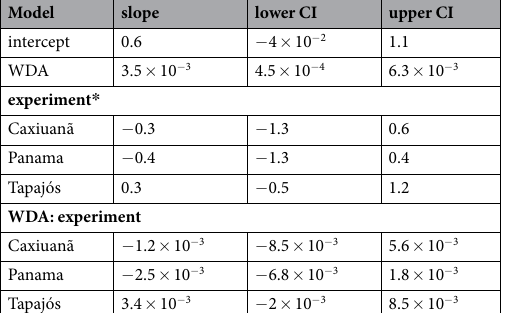
Table 3. Relationship between drought-induced mortality ( ∆ m) and water deficit affiliation (WDA) for Neotropical tree genera after accounting for experiment and phylogenetic autocorrelation using Bayesian phylogenetic mixed models. The model was fitted for all studies that had a control treatment (i.e. all except Bolivia). Values of ∆ m were standardized as z-scores for each experiment. Lower and upper CI represent respectively the lower and upper 95% credible intervals for the slope parameter. The model used an uninformative inverted gamma distribution prior for each parameter, following ref. 75. Posterior distributions were obtained from 260,000 iterations, a burn-in = 60,000, and thinning interval = 200 ref. 75. Note that WDA shows a positive relationship with ∆ m with credible intervals never overlapping zero. * Case studies were dummy coded; BCI was coded zero for each variable.